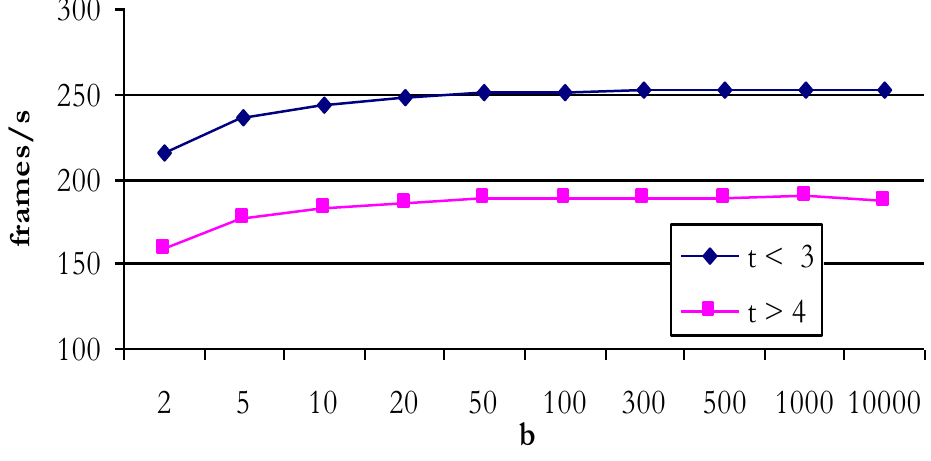
Figure 8. Ratio of images achieved per second with 1  b